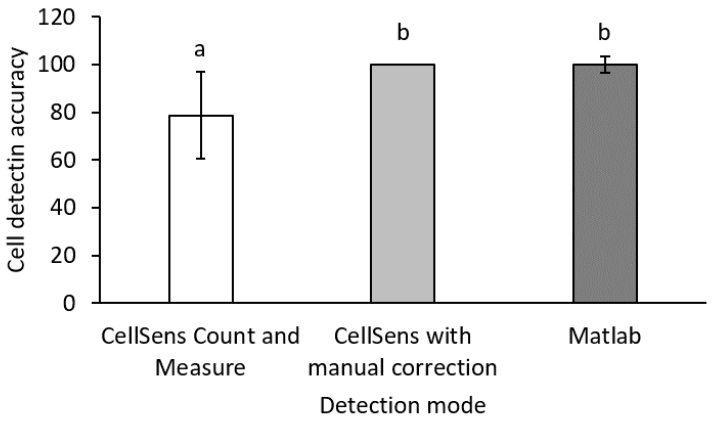
Figure 10. Comparison of the cell detection accuracy of the CellSens Count and Measure solution (Olympus, Tokyo, Japan) with and without manual correction and the custom Matlab-based evaluation. The results of the CellSens detection with manual correction were regarded as 100% reference. Results are given as means ± SD. Different letters above the bars (a and b) indicate statistical difference ( n = 8; p < 0.05).